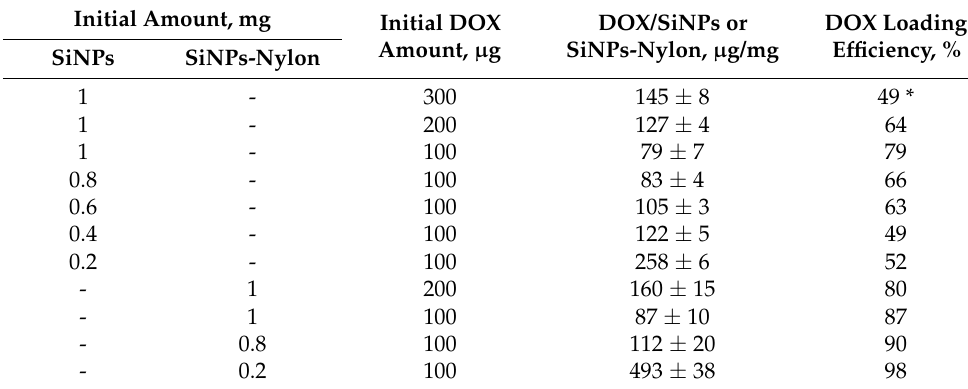
Table 3. DOX loading SiNPs and SiNPs-Nylon capacity.